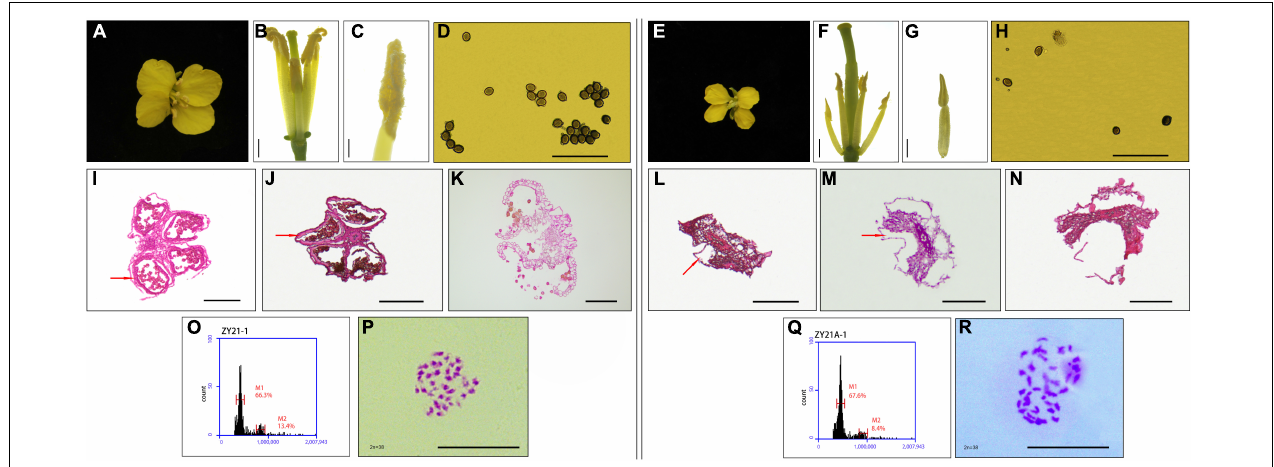
FIGURE 2 | Fertility and ploidy identification of different fertility progeny (ZY21-1 and ZY21A-1) in the induced F 1 generation. (A) Flower morphology of induced F 1 -generation fertile progeny ZY21-1. (B,C) Anther morphology of induced F 1 -generation fertile progeny (ZY21-1), (B) bar = 2mm, (C) bar = 1mm. (D) Pollen activity assay results of induced F 1 -generation fertile progeny (ZY21-1). (E) Flower morphology of induced F 1 generation sterile progeny ZY21A-1. (F,G) Anther morphology of induced F 1 generation sterile progeny (ZY21A-1), Bar = 2mm. (H) Pollen activity assay results of induced F 1 generation sterile progeny (ZY21A-1). (I–K) Induced F 1 fertile progeny (ZY21-1) with different flower bud lengths (0.2–0.25cm, 0.25–0.3cm, > 0.3cm) of anther slices, in which the red-brown arrow points to the tapetum layer. Bar = 100 µ m. (L–N) Induced F 1 sterile progeny (ZY21A-1) with different flower bud lengths (0.25–0.3cm, 0.3–0.4cm, > 0.4cm) of anther slices. The position indicated by the red-brown arrow indicates that the tapetum layer has degenerated. Bar = 100 µ m. (O) Flow cytometry results of induced F 1 generation fertile progeny ZY21-1. (P) Number of the chromosome of induced F 1 generation fertile progeny ZY21-1, Bar = 10 µ m. (Q) Flow cytometry results of induced F 1 generation sterile progeny ZY21A-1. (R) Number of the chromosome of induced F 1 generation sterile progeny ZY21A-1, Bar = 10 µ m.